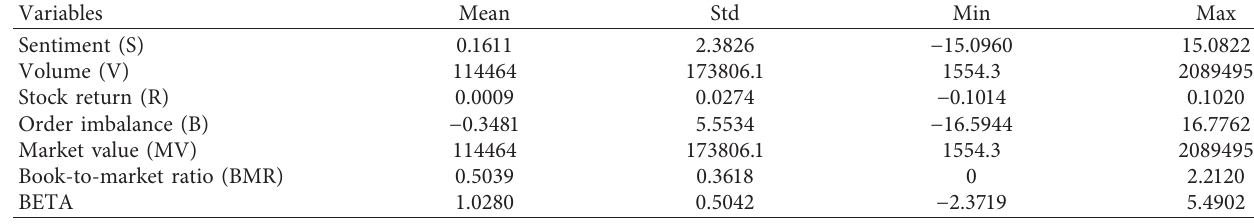
Table 2: Descriptive statistics.